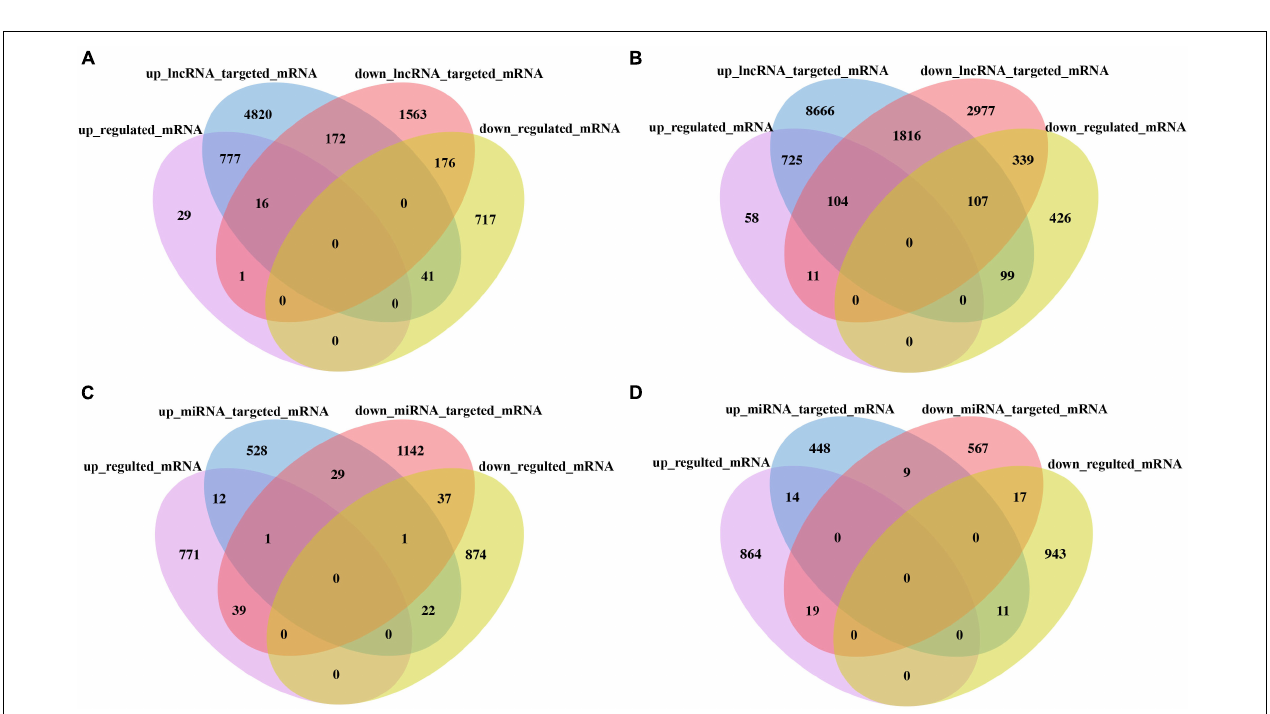
FIGURE 8 | Analysis of the targeted mRNA of lncRNA and miRNA between the hybrid and its parents. (A) Venn diagram of DE lncRNA targeted mRNA between HNCy01 and HNCc22. (B) Venn diagram of DE lncRNA targeted mRNA between HNCy01 and HNCc16. (C) Venn diagram of DE miRNA targeted mRNA between HNCy01 and HNCc22. (D) Venn diagram of DE miRNA targeted mRNA between HNCy01 and HNCc16.